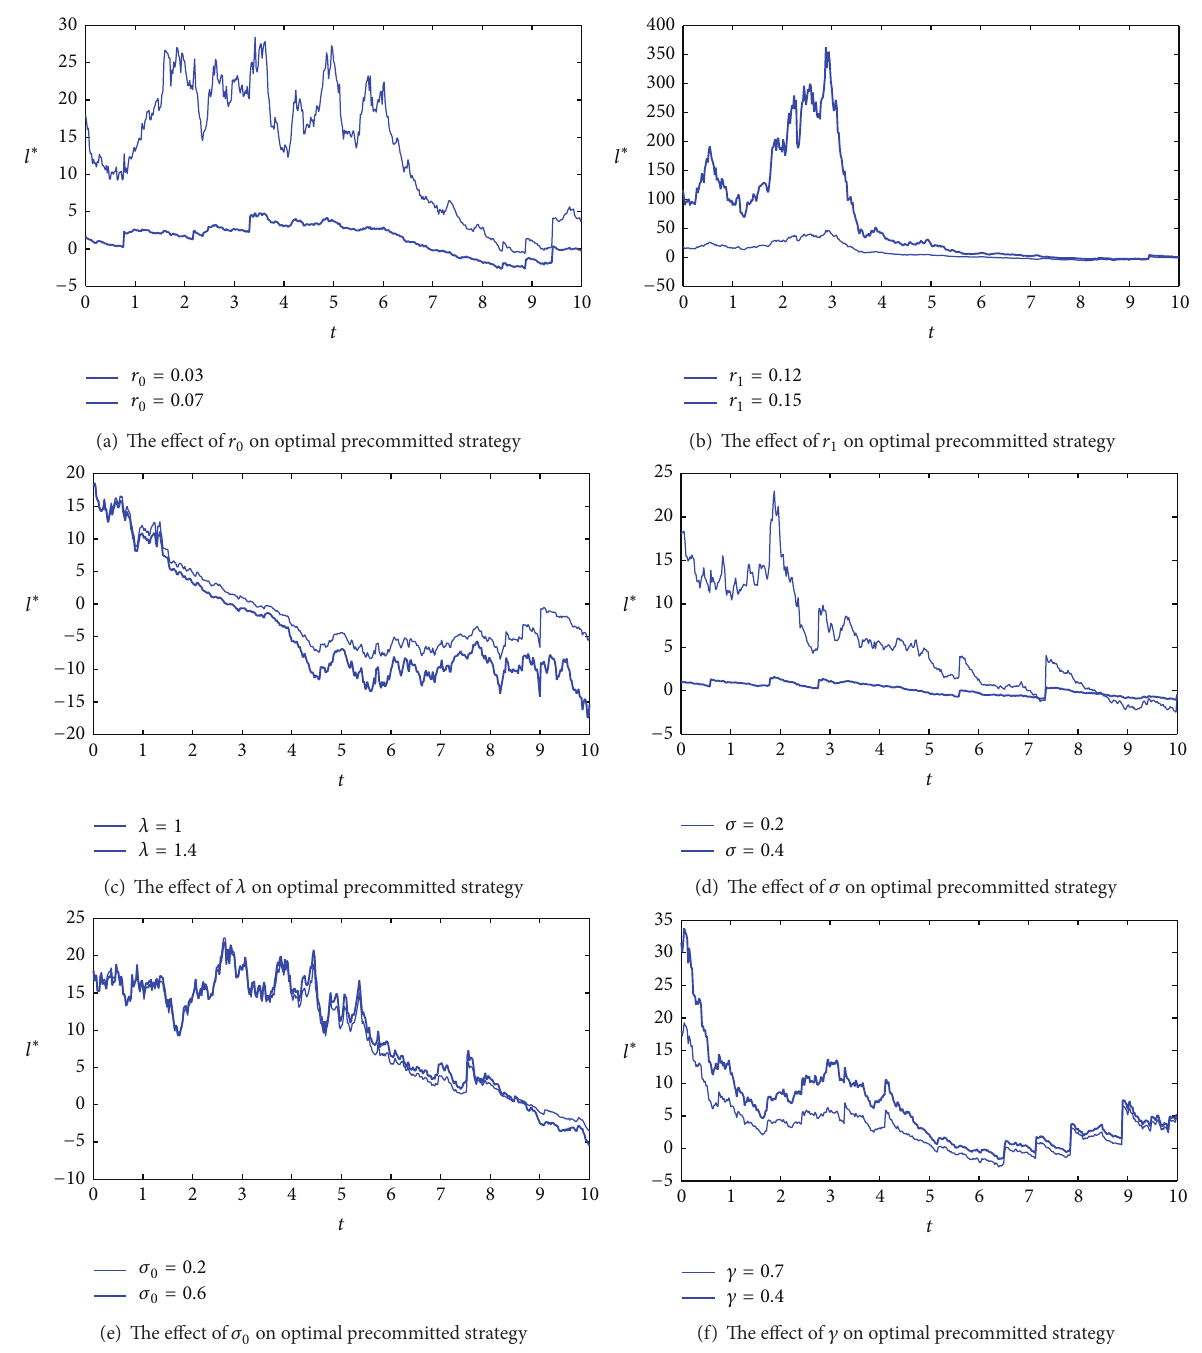
(f) The effect of 𝛾 on optimal precommitted strategy Figure 2: The effect of parameters on optimal precommitted strategy for the C-L risk